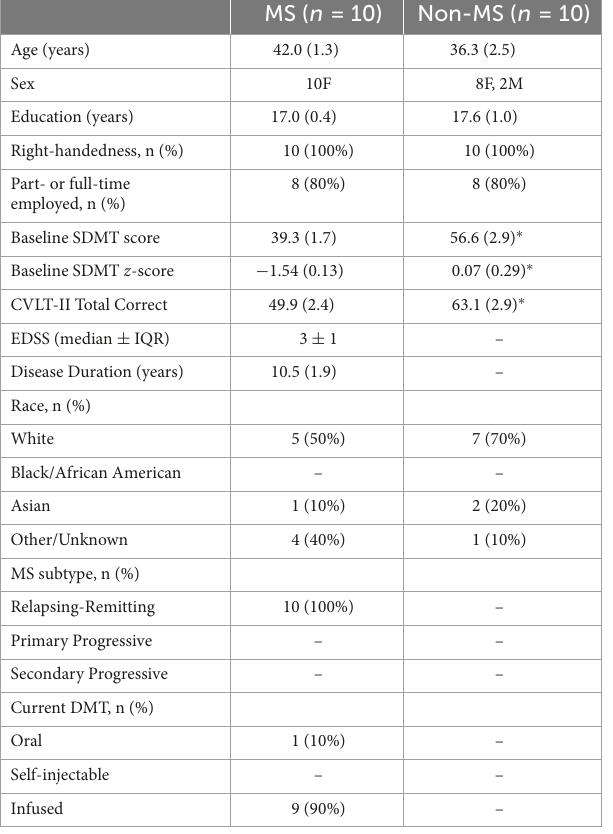
TABLE 2 Baseline demographic and clinical characteristics of participants enrolled in the study.